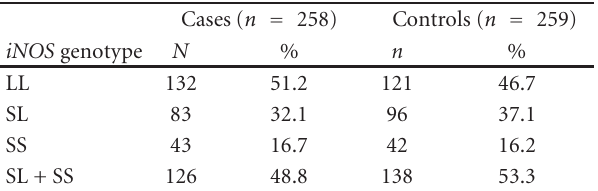
Table 2: Frequencies of iNOS genotypes in cases and controls.